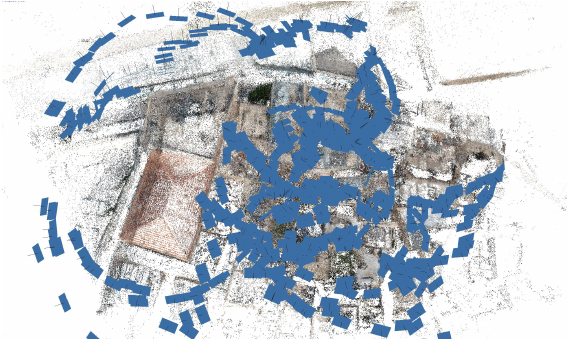
Figure 12: The fronts integration between DJI Spark and the SfM acquisition with SLR